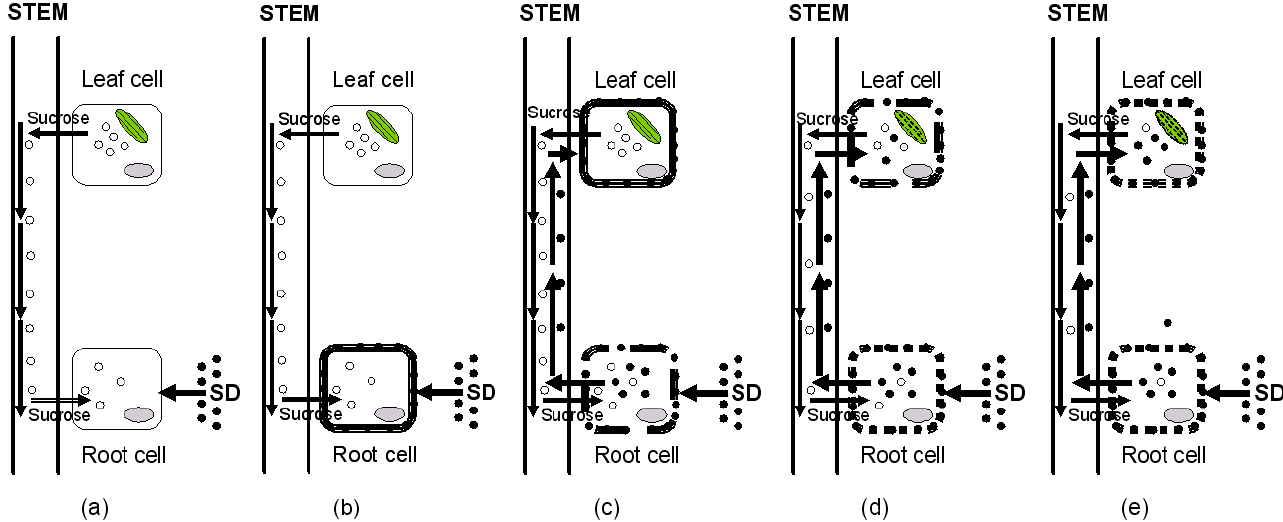
Figure 7. Proposed toxicity mechanism of accumulated SD in lettuces grown in SD stressed culture solutions. ( a ) lettuce at first contact with SD; ( b ) thickening of the lettuce root cell in the SD-stressed; ( c ) lettuce root cell damage and SD translocated from the roots to the leaves; ( d ) lettuce leaf cell damage and SD damage to the chloroplasts; ( e ) lettuce leaf cell broken, thus ultimately inhibiting plant growth.